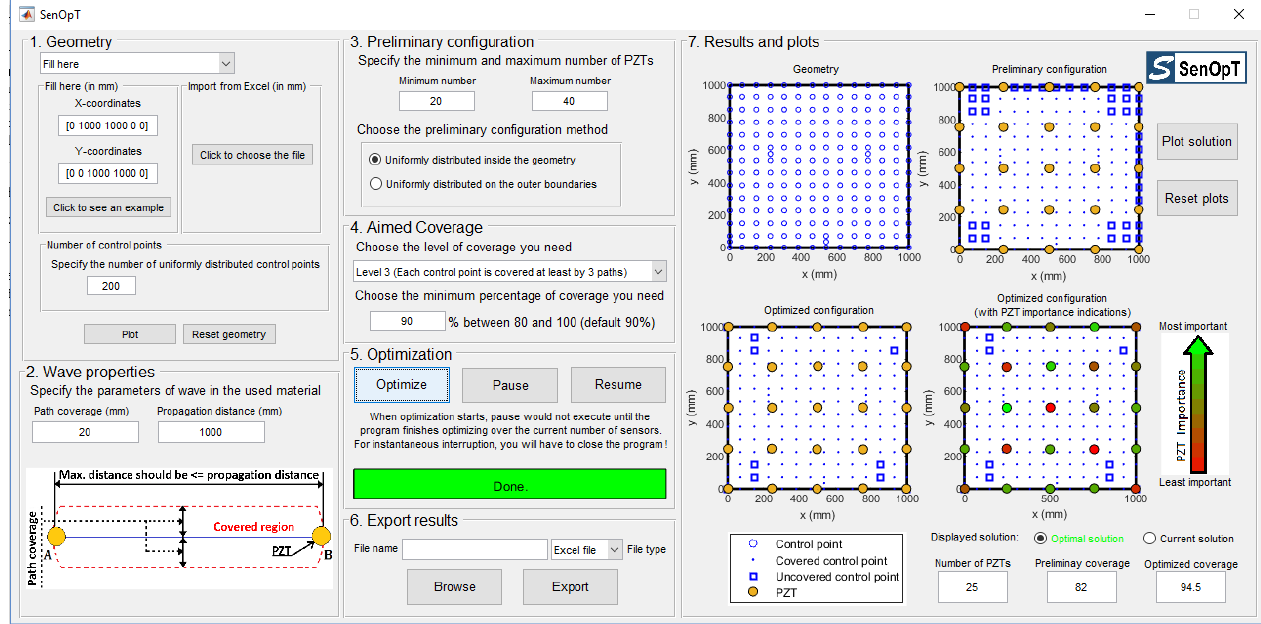
Figure 2. Snapshot of the SenOpT optimizer for placement of PZT wafers.